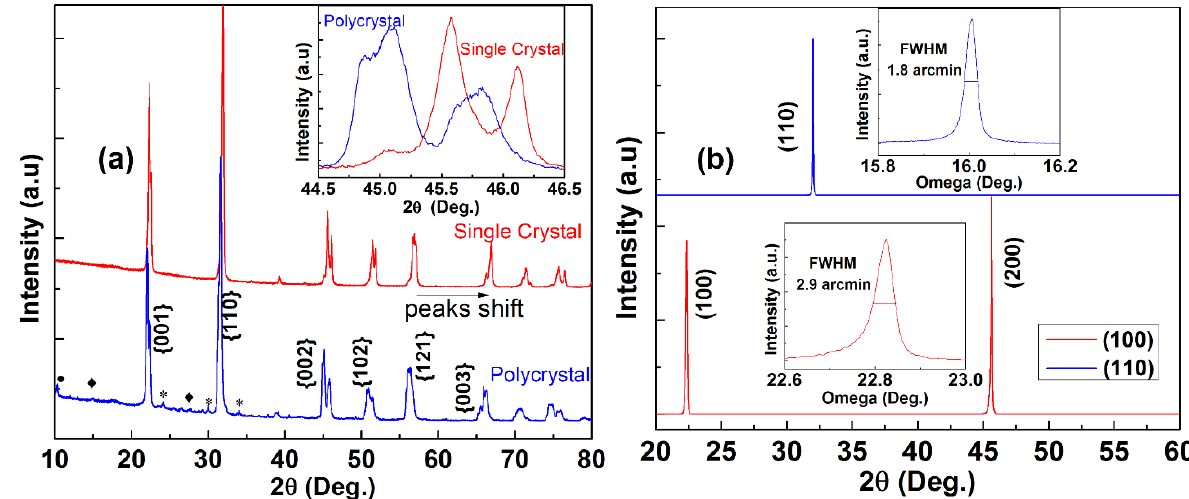
( b ) X-ray diffractograms of the (110)-oriented single crystal (top) and of the